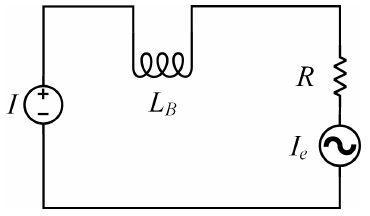
Figure 11. Equivalent circuit diagram of macro-motion